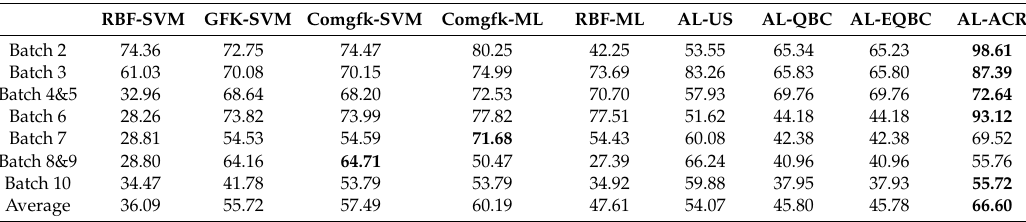
Table 1. Accuracy of methods in Scenario 1